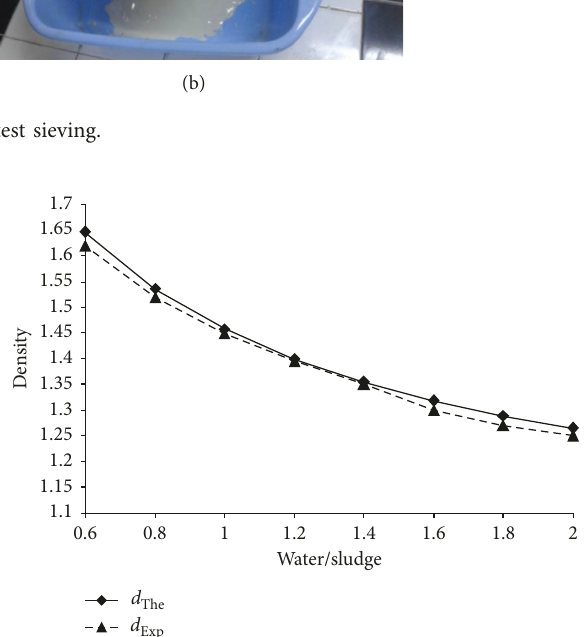
Figure 5: Experimental and theoretical densities and water/sludge ratio